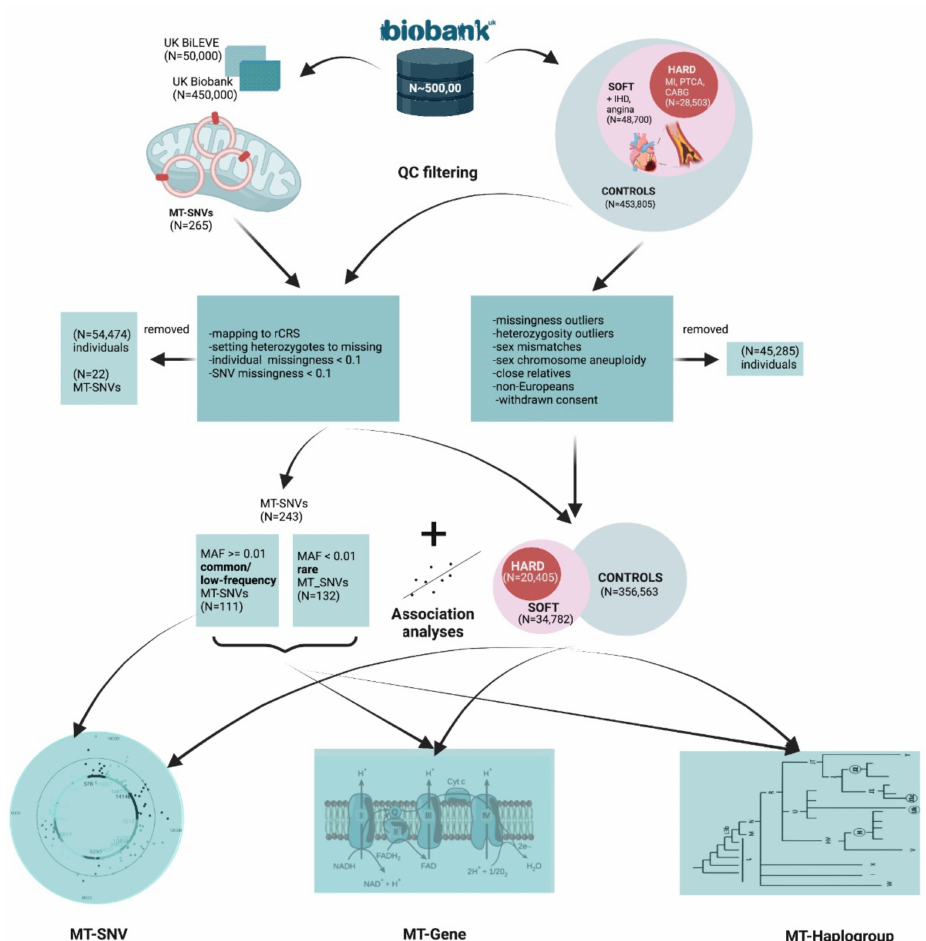
Figure 1. A complete workflow of the analyses performed. Created with Biorender.com (accessed on 22 February